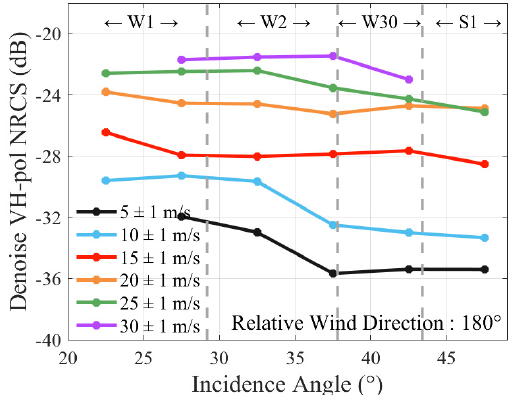
Figure 7. Influence of the incidence angle on cross-polarized NRCS for different wind speeds.